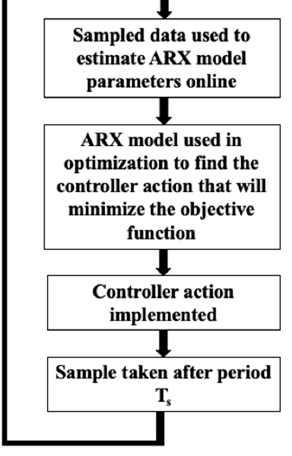
Figure 3. The adaptive MPC.